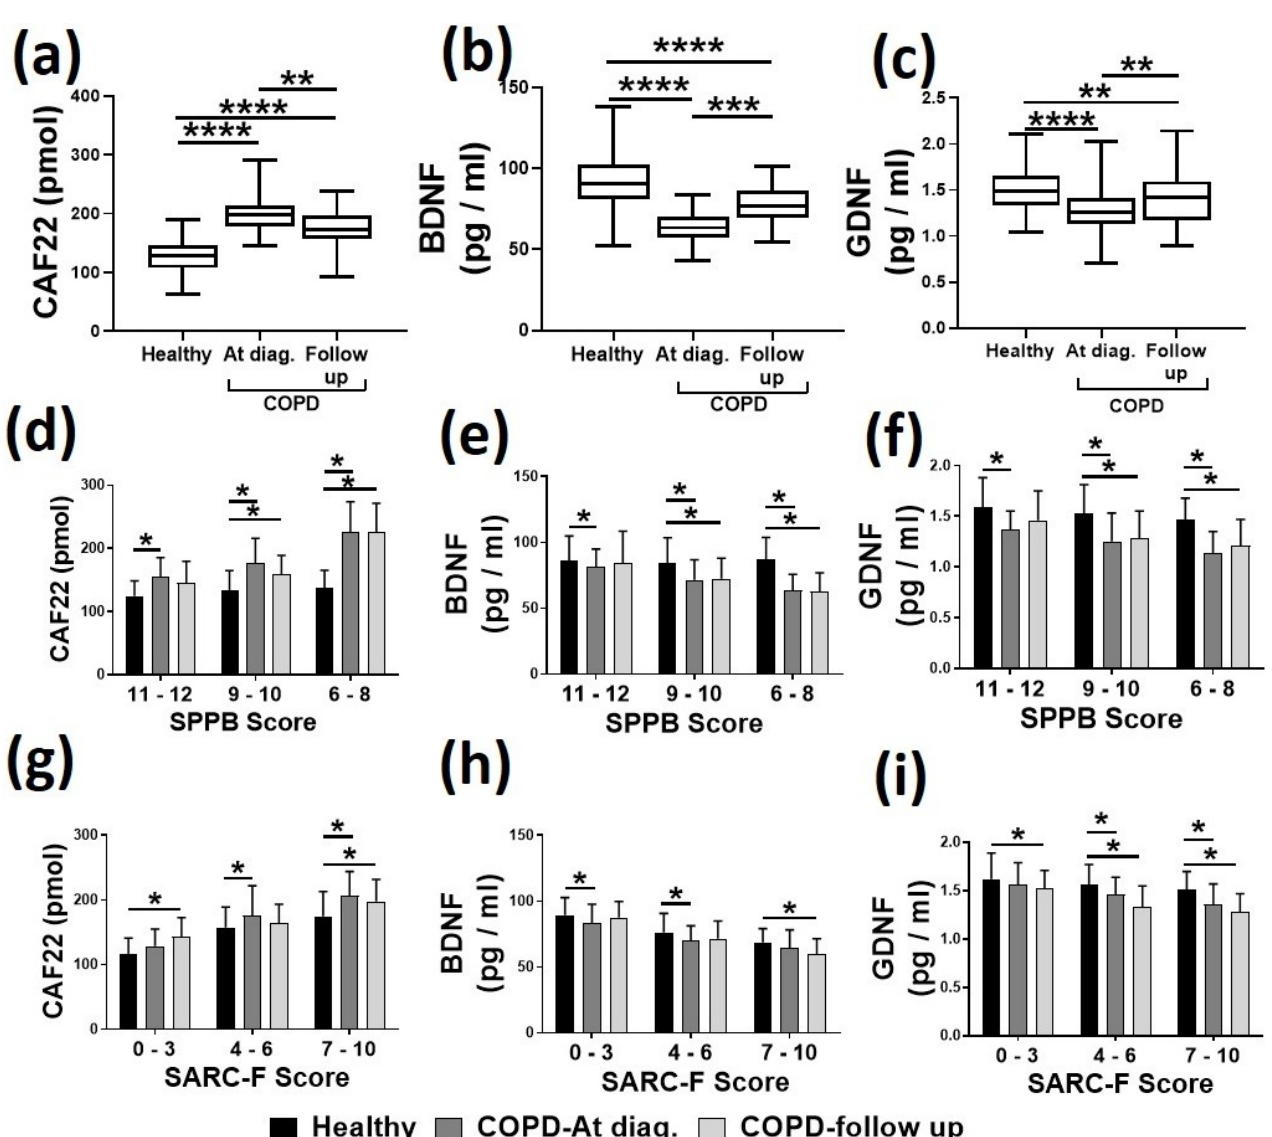
Figure 3. Comparison of circulating CAF22 ( a , d , g ), BDNF ( b , e , h ), and GDNF ( c , f , i ) levels in healthy controls and patients with COPD ( n = 77–84/group). The biomarkers levels were higher in COPD patients at diagnosis (Dx) and partially restored to normal levels with pulmonary rehabilitating. Poor performance on SBBP ( d , e , f ) and SARC-F ( g , h , i ) were associated with higher CAF22 and lower BDNF and GDNF levels. Values are expressed as mean ± SD, one-way analysis of variance. * p < 0.05, ** p < 0.01, *** p < 0.001, **** p < 0.0001.